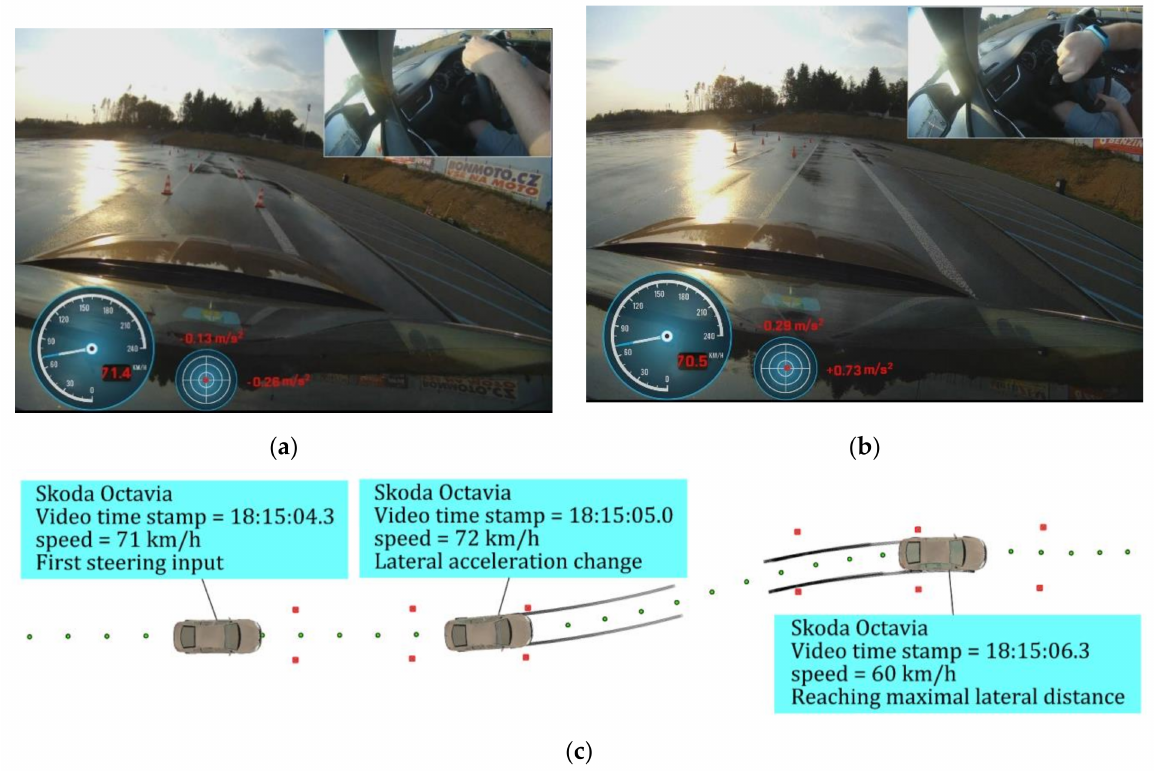
Figure 2. Example of determining the beginning and end of the manoeuvre during test series 3: ( a ) first steering input; ( b ) first discernible change of lateral acceleration and vehicle direction; ( c ) overview of the whole manoeuvre with traffic cones outlining the track and green dots representing the vehicle